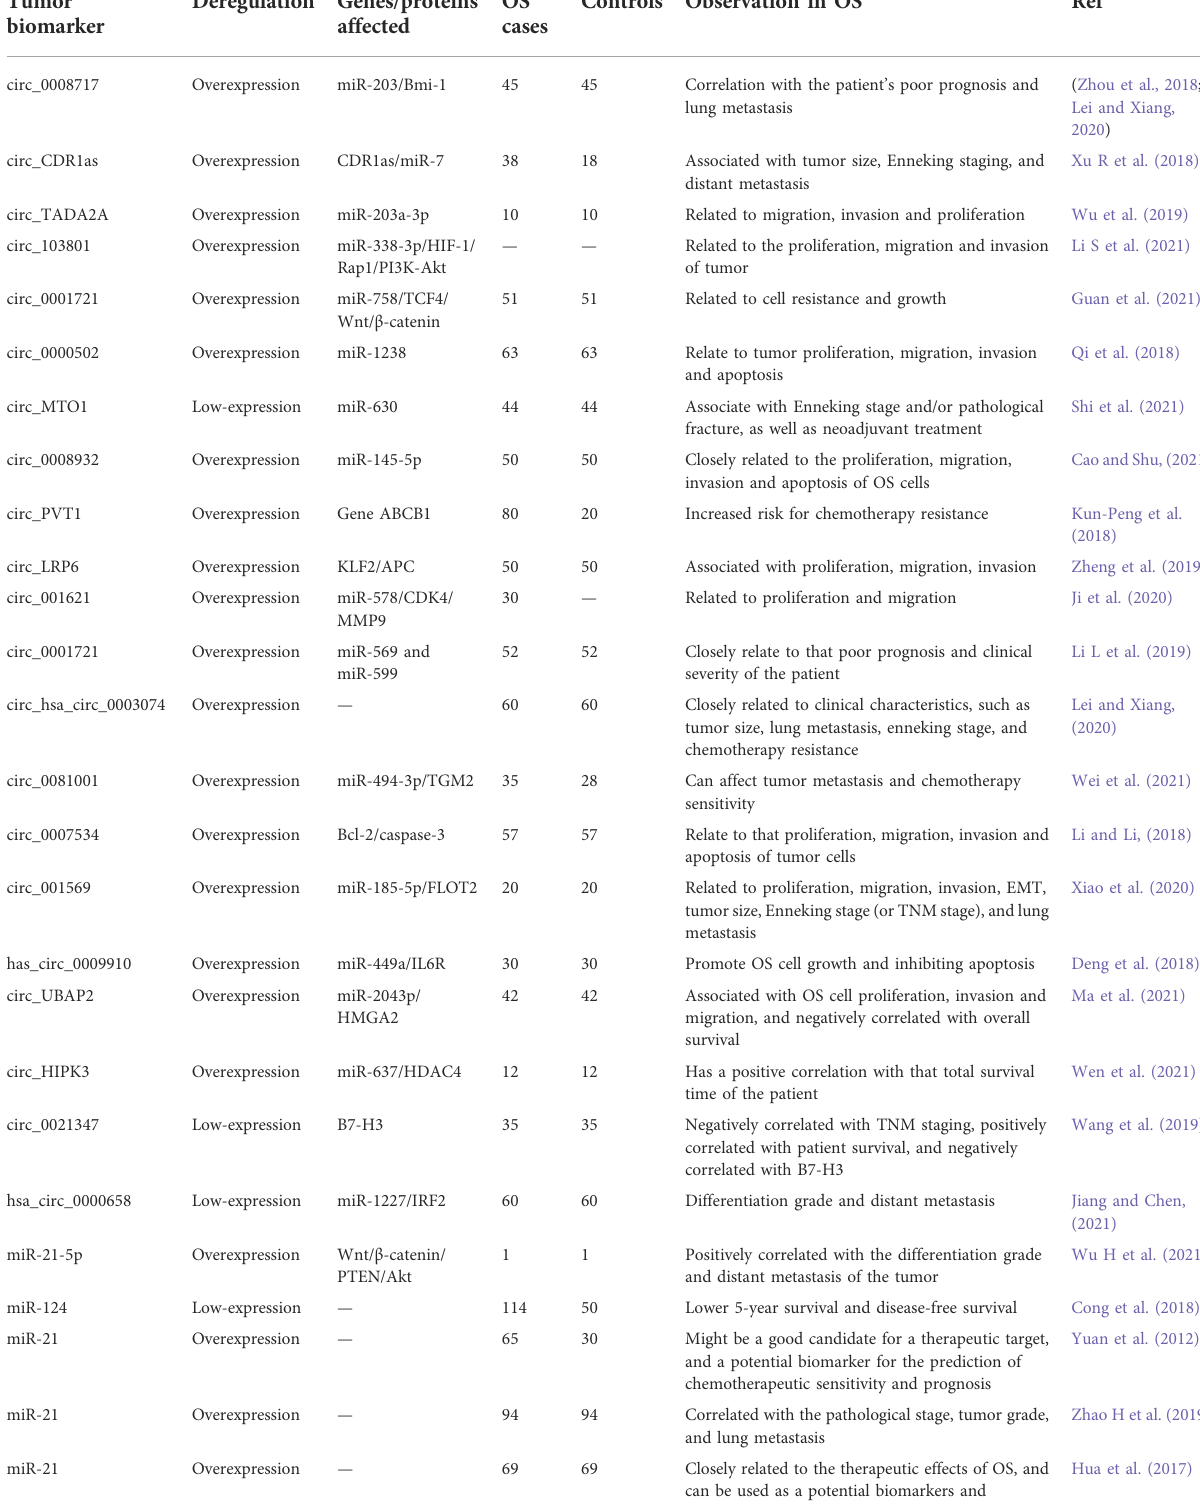
TABLE 1 Identi fi cation of NcRNA Tumor Biomarkers analyzed in multiple studies. Tumor